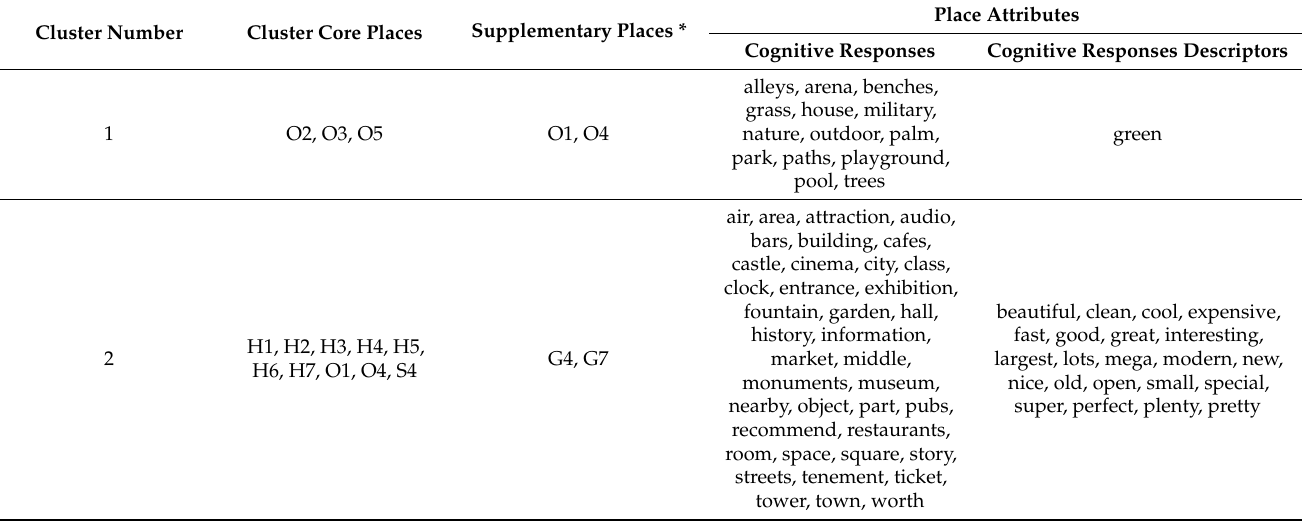
Table 5. Results of hierarchical clustering with regards to core and supplementary cluster places and place attributes dimension terms most related to the